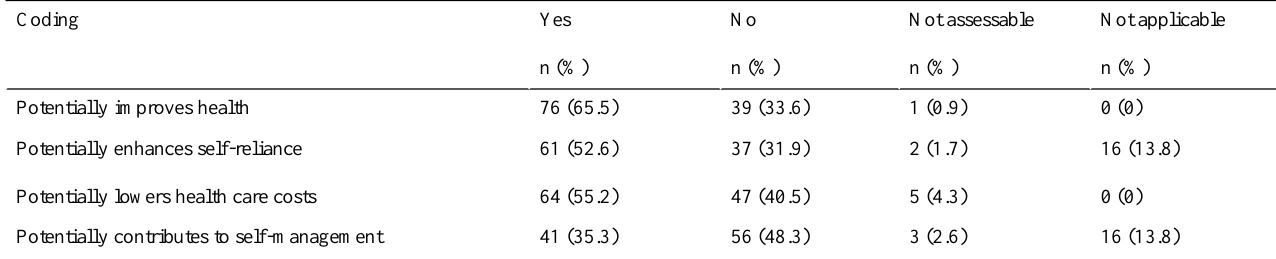
Table 1. Table . Assessment of possible benefits of apps and other e-tools for medication use; data is presented as percentage of total number of tools investigated